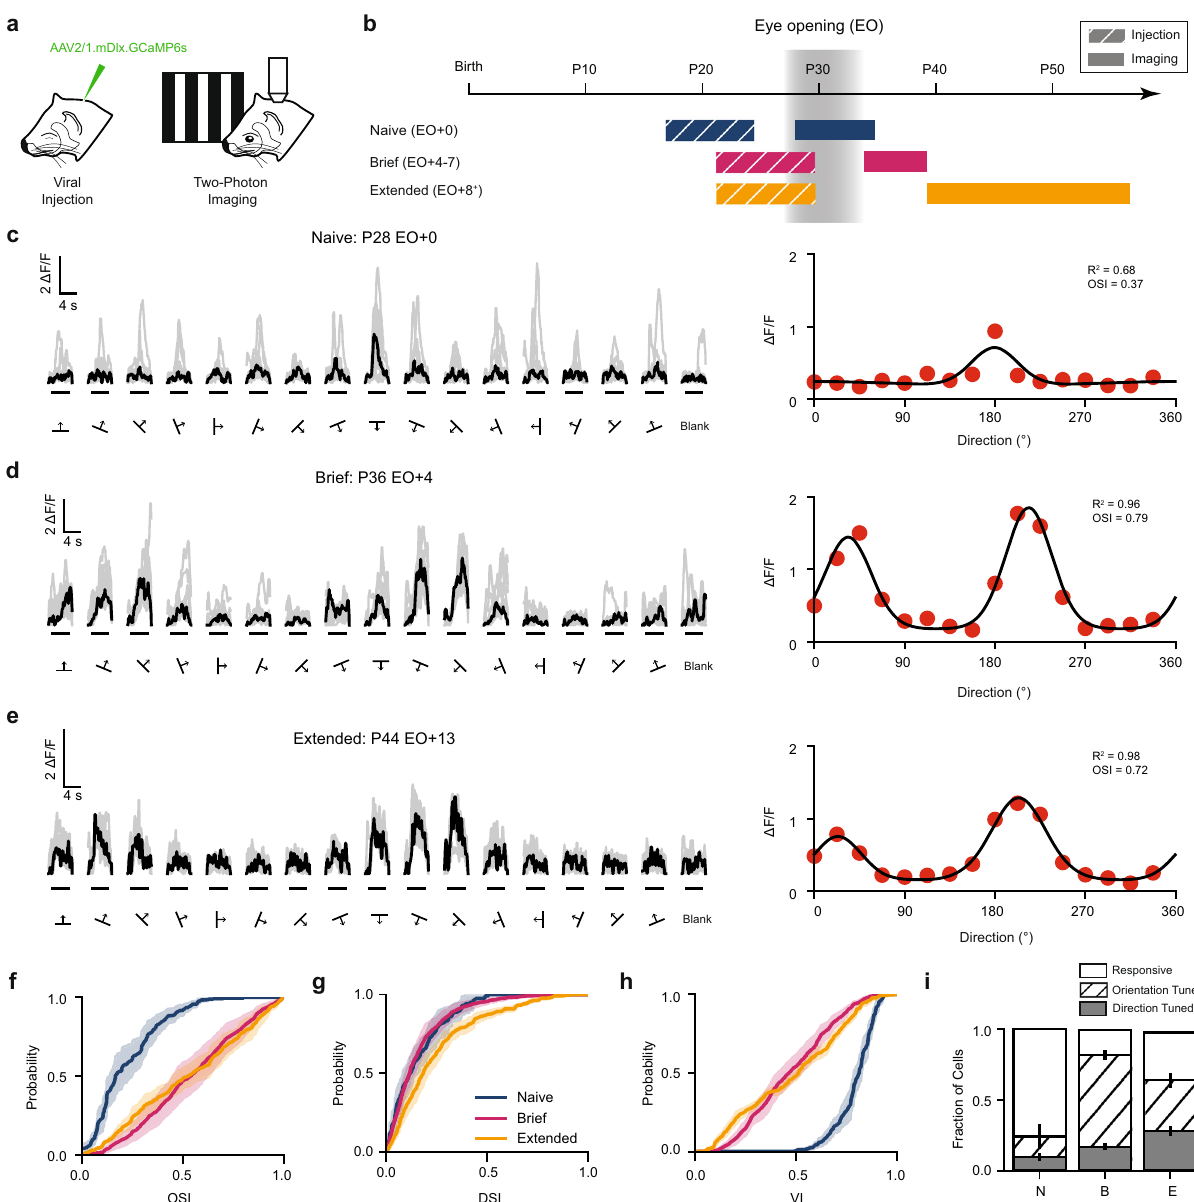
Fig. 1 Orientation selectivity strengthens in interneurons after eye opening. a Two-photon imaging of viral expression of GCaMP6s under the mDlx enhancer in ferret visual cortex. The ferret images were created by the authors and published in Smith, G.B., Sederberg, A., Elyada, Y.M., Van Hooser, S.D., Kaschube, M., and Fitzpatrick, D., The development of cortical circuits for motion discrimination. Nat. Neurosci. 18, 252 – 261 (2015). b Three age groups, Naive (EO + 0), Brief experience (EO + 4 – 7), and Extended experience (EO + 8 + ). c Example cellular responses to square drifting gratings (left, black traces denote median response and gray traces denote single trials) and responsive tuning curve (right) for a Naive animal. d , e same as ( c ) but for a Brief and Extended experience animal respectively. f – h Cumulative distributions of orientation selectivity index ( f ), direction selectivity ( g ), and variability index ( h ) for Naive (blue, n = 7), Brief (magenta, n = 6), and Extended (gold, n = 5) experience animals. Shaded regions denote SEM. i Fraction of cells that are responsive (white), orientation selective (hatched), and direction selective (gray) for Naive (N, n = 7), Brief (B, n = 6), and Extended (E, n = 5) experience animals. Error bars denote SEM. Source data are provided as a Source Data fi re fl ects activity indistinguishable from spontaneous activity. For all age groups, GABA-INs had SAIs signi fi cantly larger than zero, (Supplementary Fig. 1a, SAI Naive 1.43 ± 0.05, p < 0.0001, n = 233 cells; Brief 1.00 ± 0.03, p < 0.0001, n = 966 cells; Extended 0.17 ± 0.04, p < 0.0001, n = 326 cells; Mean ± SEM, Students ’ t test). Thus, even at the non-preferred orientation, visual